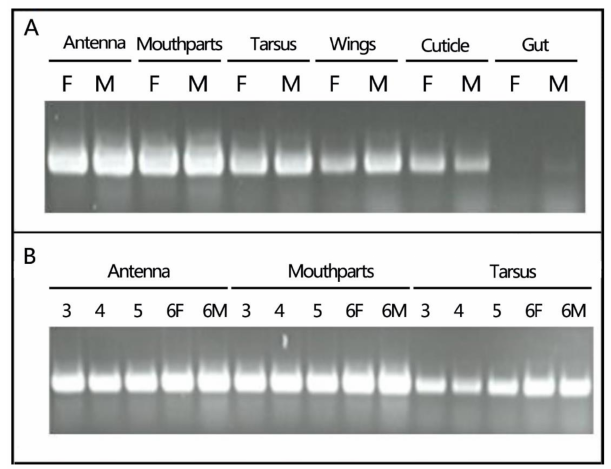
Figure 1. Spatial and temporal expression patterns of Lmig CSPIII, as detected by RT-PCR. ( A ) Similar expression profiles of Lmig CSPIII shared in several chemosensory organs in new emerged female (F) and male (M) adult L. migratori a. ( B ) Lmig CSPIII was detected at both nymphal and adult stages in the antenna, mouthparts, and tarsi; 3, 4, 5 represent locust nymphs at third, fourth or fifth instar; six, adults; F, female; M, male.